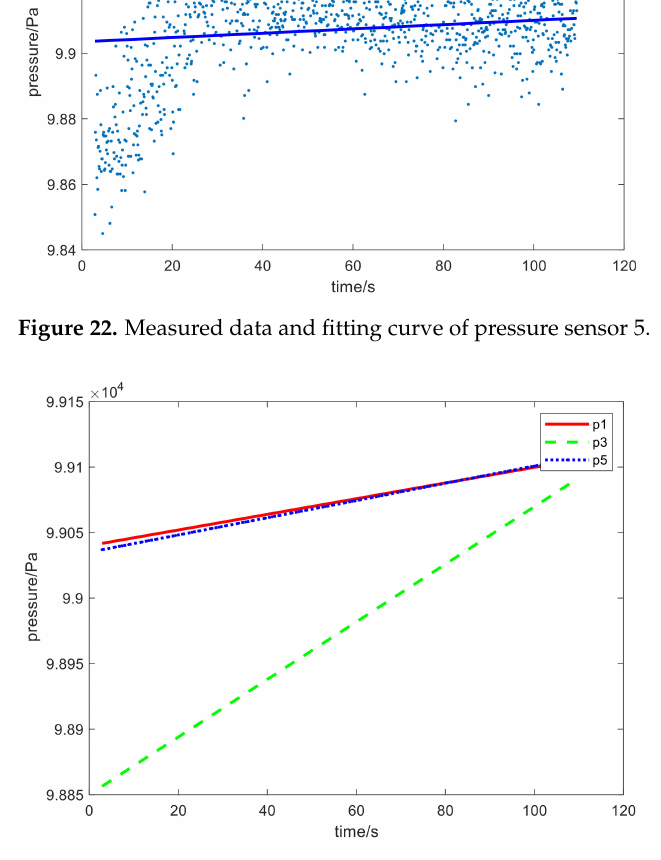
Figure 23. Comparison of pressure sensor fitting curves.